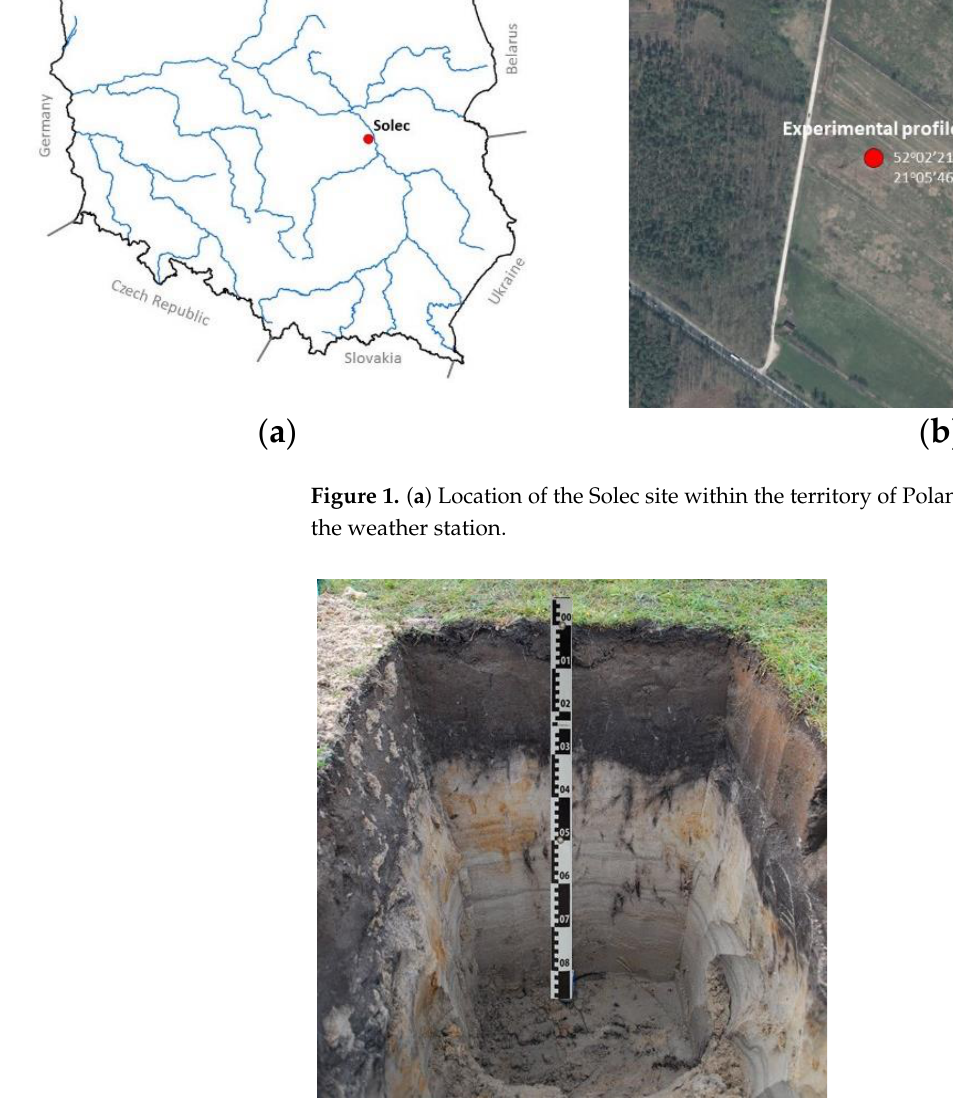
Figure 2. The profile of the analysed soil.